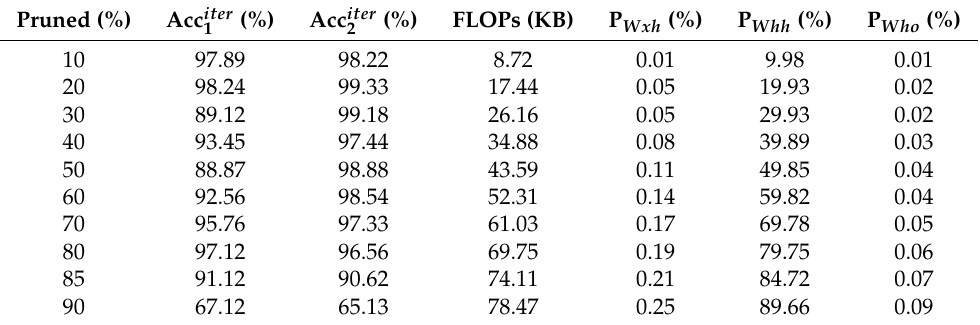
Table 7. Iterative layer-wise pruning performance of the model with 120 hidden neurons. P w (%) denotes the percentage of the removed weights over the entire network in different pruning rates. Pruned